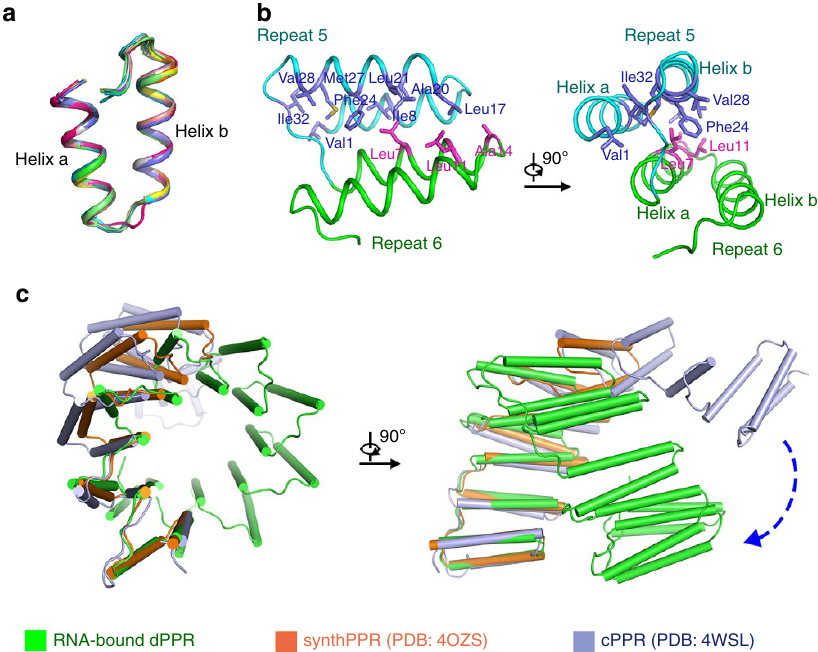
Figure 3 | Structural plasticity of U 8 C 2 . ( a ) All dPPR repeats of dPPR-U 8 C 2 exhibit a nearly identical conformation. Each repeat is organized into two helices (a and b) followed by a short loop. ( b ) The contact between adjacent dPPR repeats is primarily mediated by van der Waals interactions. Repeats 5 and 6 from dPPR-U 8 C 2 are coloured cyan and green, respectively. Two perpendicular views are presented, with amino acids that participate in the interaction shown in violet and magenta at repeats 5 and 6, respectively. ( c ) RNA-bound dPPR-U 8 C 2 exhibits a more compressed conformation than RNA- free cPPR and synth PPR3.5. The three structures are superimposed using the first PPR repeat of each protein, and dPPR-U 8 C 2 , cPPR and synth PPR3.5 are coloured green, light blue and orange. The blue dashed arrow indicates the conformational differences between dPPR-U 8 C 2 and